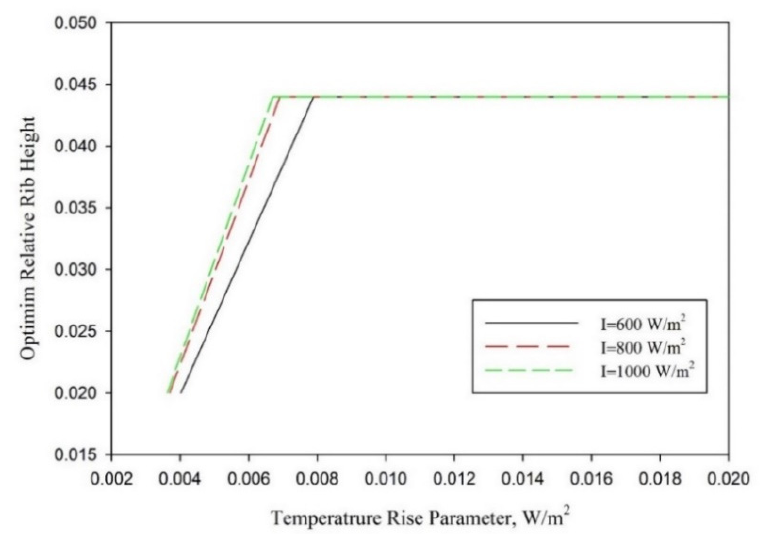
Figure 12. Optimum value of relative rib height.